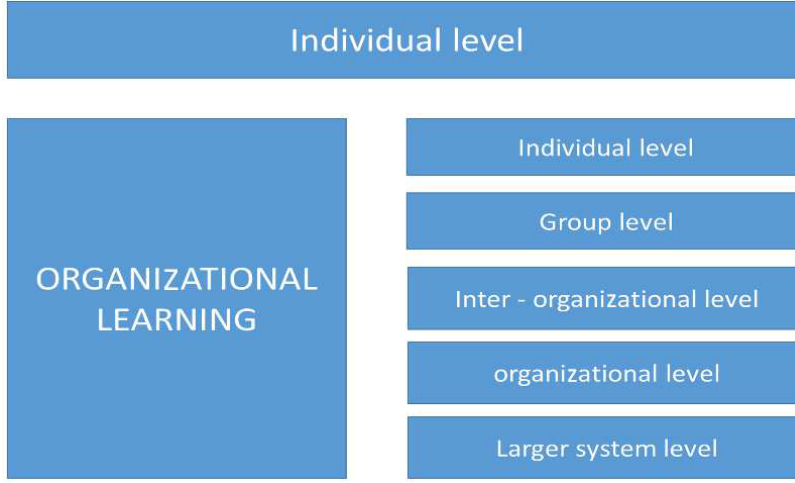
Fig. 2. The flow of learning across levels